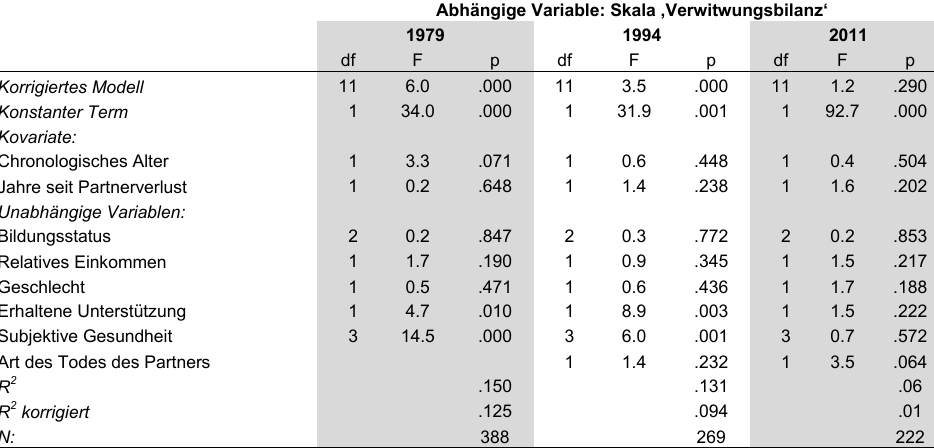
Methode: Multivariate Varianzanalyse (general linear model) Bildungsstatus: dreistufig: a) nur obligatorische Schule, ohne weiterführende berufliche Ausbildung, b) berufliche Fachausbildung (Lehre u.a.), c) Tertiäre Ausbildung (Fachhochschule, Universität). Relatives Einkommen: zweistufig: a) Haushaltseinkommen geringer als Medianwert, b) Haushaltsein- kommen höher als